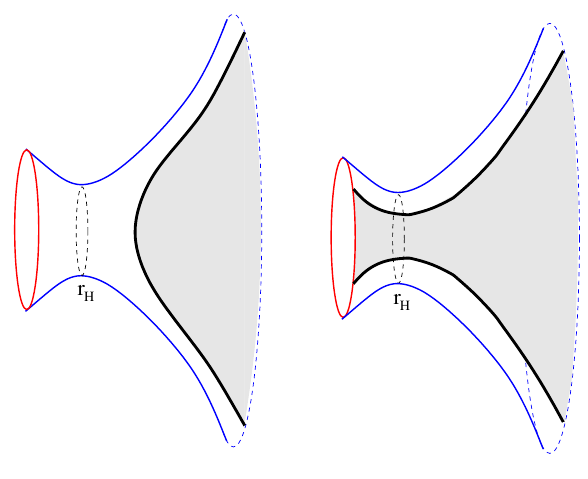
Figure 2 . Two possibilities for extremal surfaces and associated entanglement wedges (shaded) for ball-shaped boundary regions. The extremal surface on the right has the topology of S d (cid:0) 2 times an interval, so is connected for d >